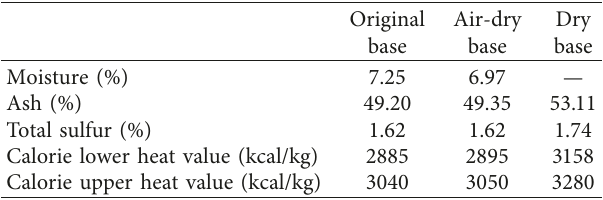
Table 6: Chemical analysis results of Sample-C2 coal.